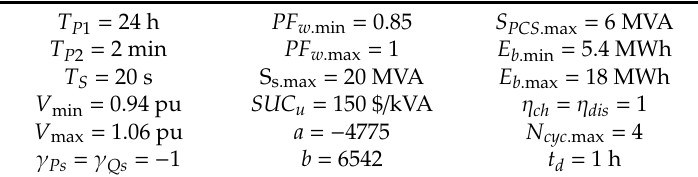
Table 1. Data for the case study taken and adapted from